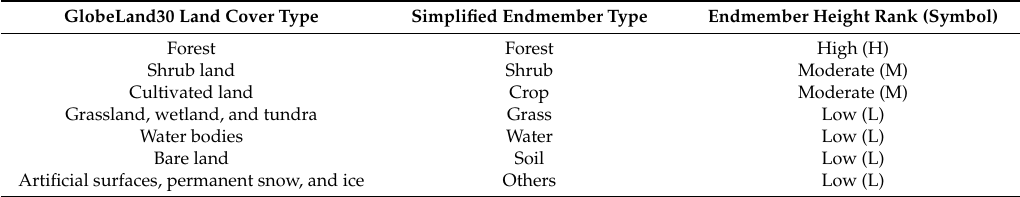
Table 1. Simplified endmember types and height rank of the corresponding GlobeLand30 land cover types.